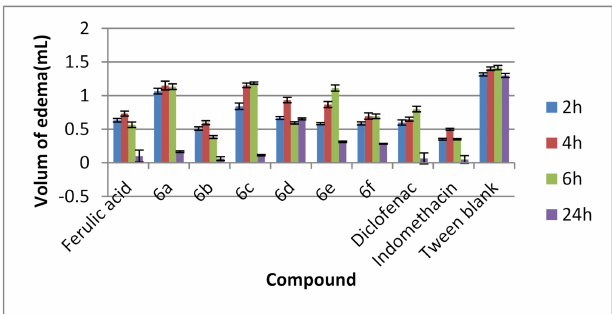
Figure 3. Variation in the inflammatory edema volume of the rat paw in the groups treated with 6 a–f derivatives (concentration being 1 / 10 of LD50), ferulic acid (concentration being 1 / 10 of LD50), diclofenac sodium (5 mg / kg body weight), indomethacin (1.5 mg / kg body weight), and the control group at 2, 4, 6, and 24 h. (Legend: concentrations for 6a (R = H) = 118, 75 mg / kg body weight; 6b (R = 4-F) = 175 mg / kg body weight; 6c (R = 4-Cl) = 169 mg / kg body weight; 6d (R = 2-NO 2 ) = 145 mg / kg body weight; 6e (R = 4-Br) = 165 mg / kg body weight; 6f (R = 2-OH) = 178 mg / kg